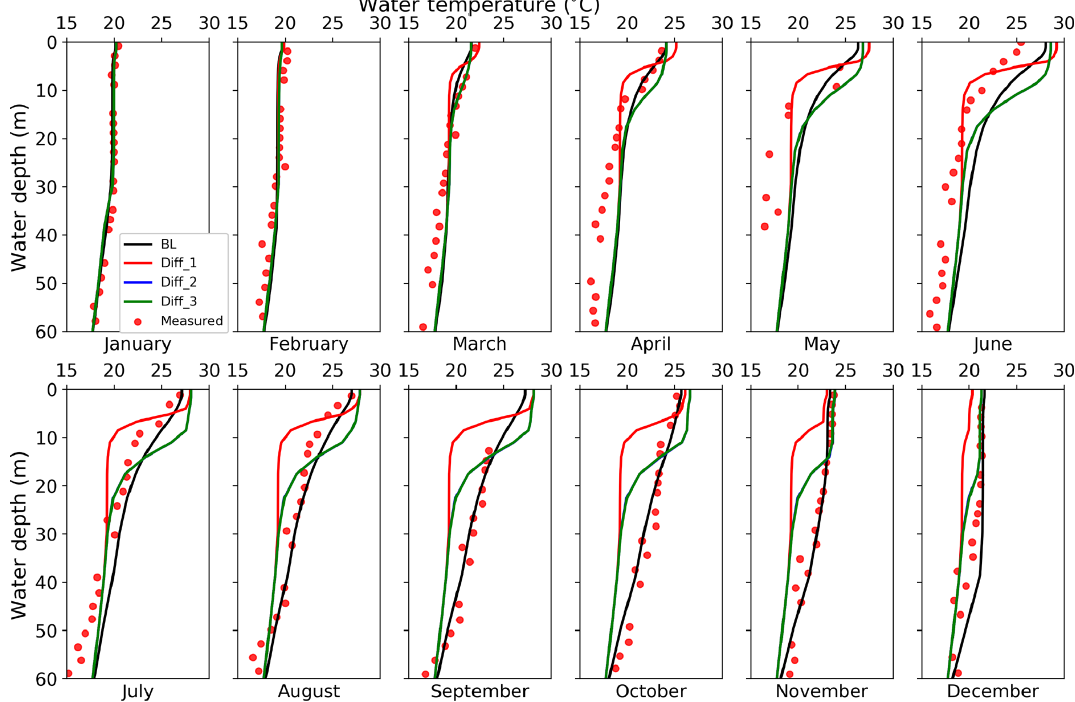
Figure 8. Monthly vertical temperature profiles for the first 60m water by observation (red dots), BL (black line), Diff_1 (red line), Diff_2 (blue line), and Diff_3 (green line) in the year 2015. Note Diff_2 and Diff_3 overlap each